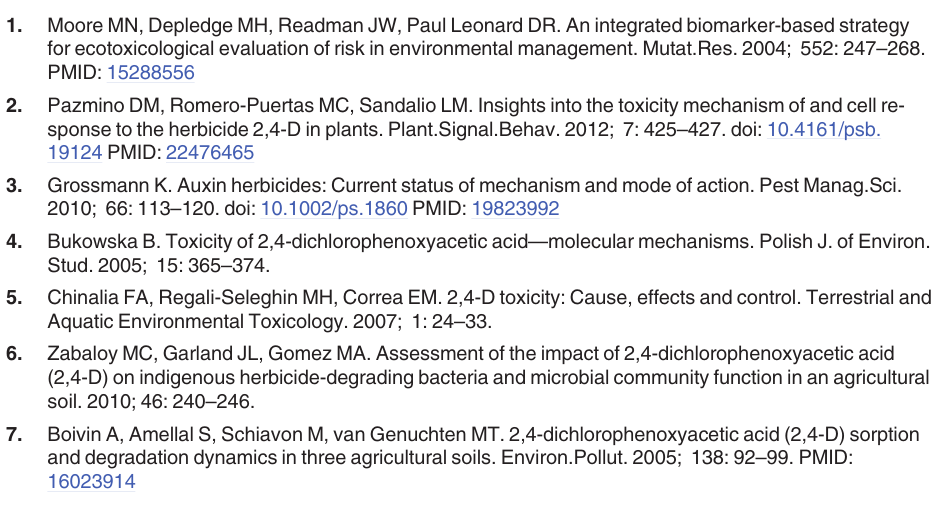
S4 Fig. ICL assay showing no difference in activity with 2,4-D treatment. Increase in phenyl- hydrazone derivative levels was measured as absorbance at 324 nm for 30 min. There was no difference in activity as a function of treatment type, as shown by the close parallel lines of all sample sets (p > 0.05).